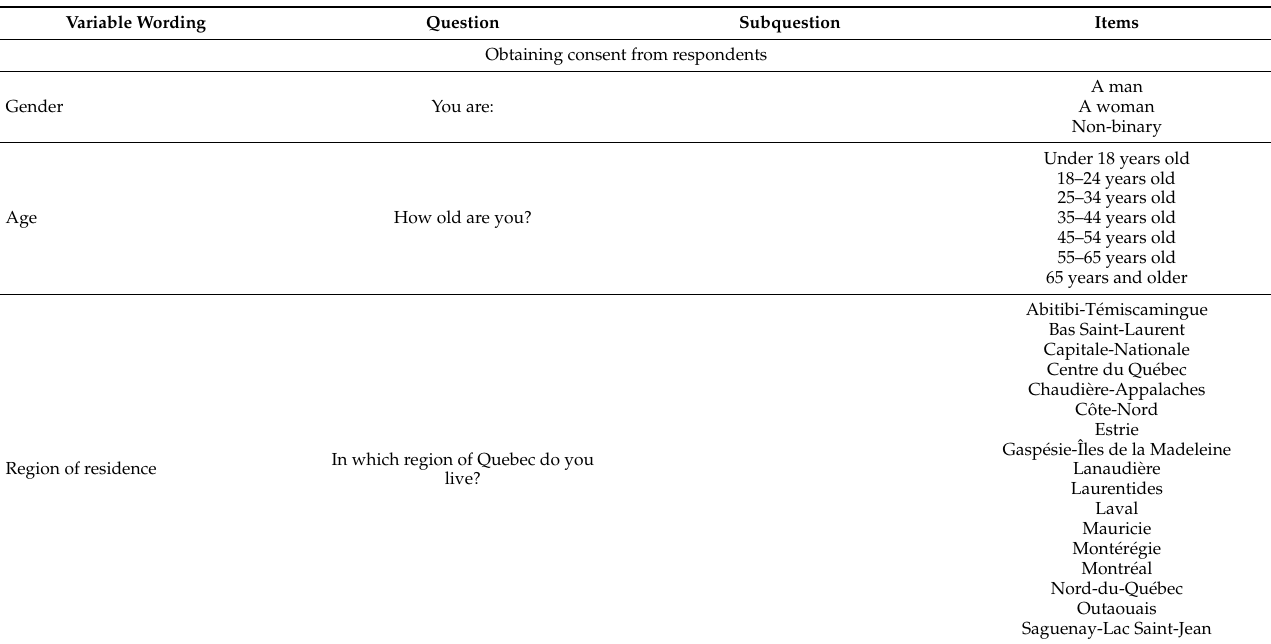
Table A1. Questionnaire used for this